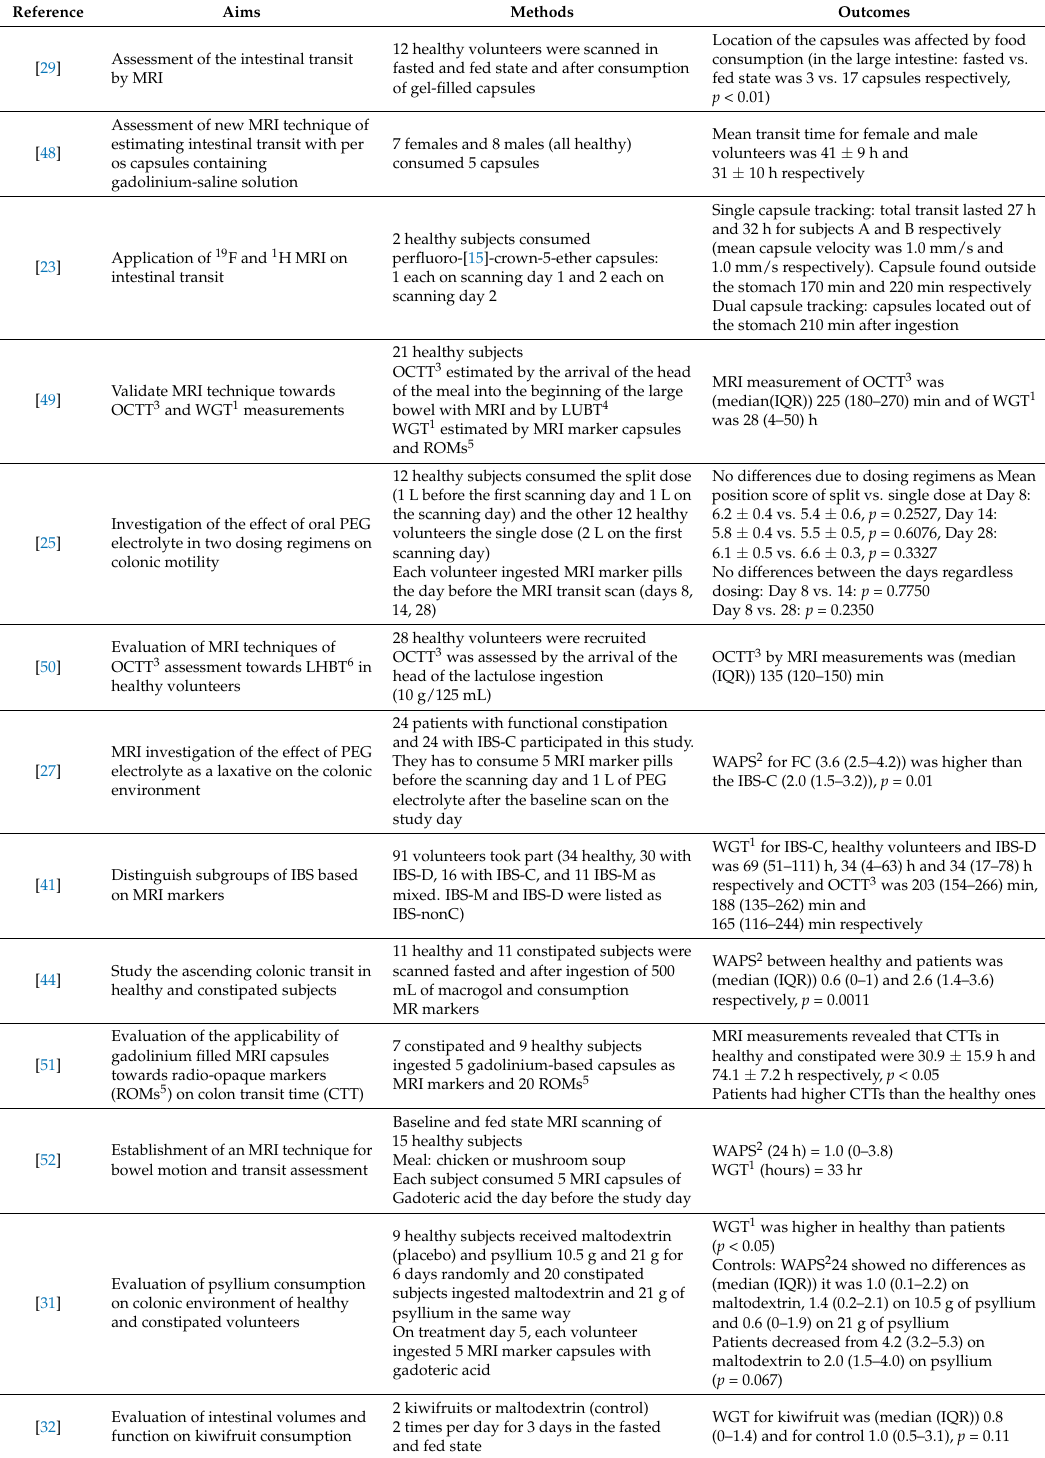
WGT 1 : whole gut transit WAPS 2 : median average weighted position score OCTT 3 : orocecal transit time LUBT 4 : lactose ureide breath test ROMs 5 : radio-opaque markers LHBT 6 : lactulose hydrogen breath